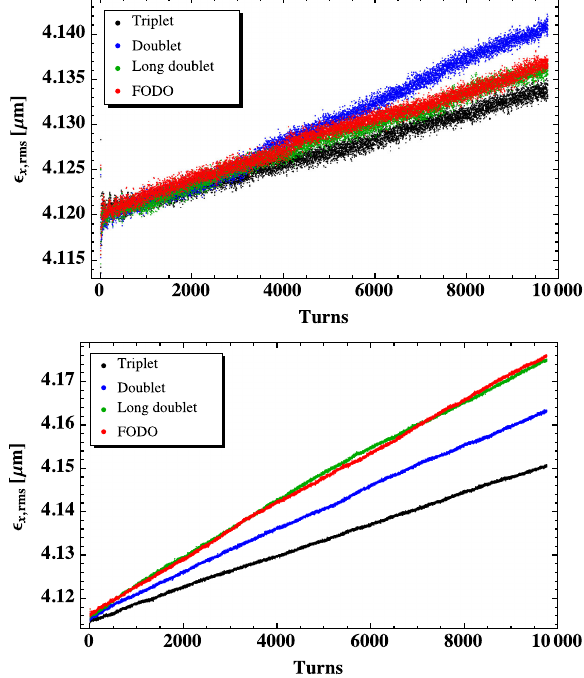
FIG. 5. Time evolution of horizontal (top) and vertical (bottom) rms emittance for different lattice cells.